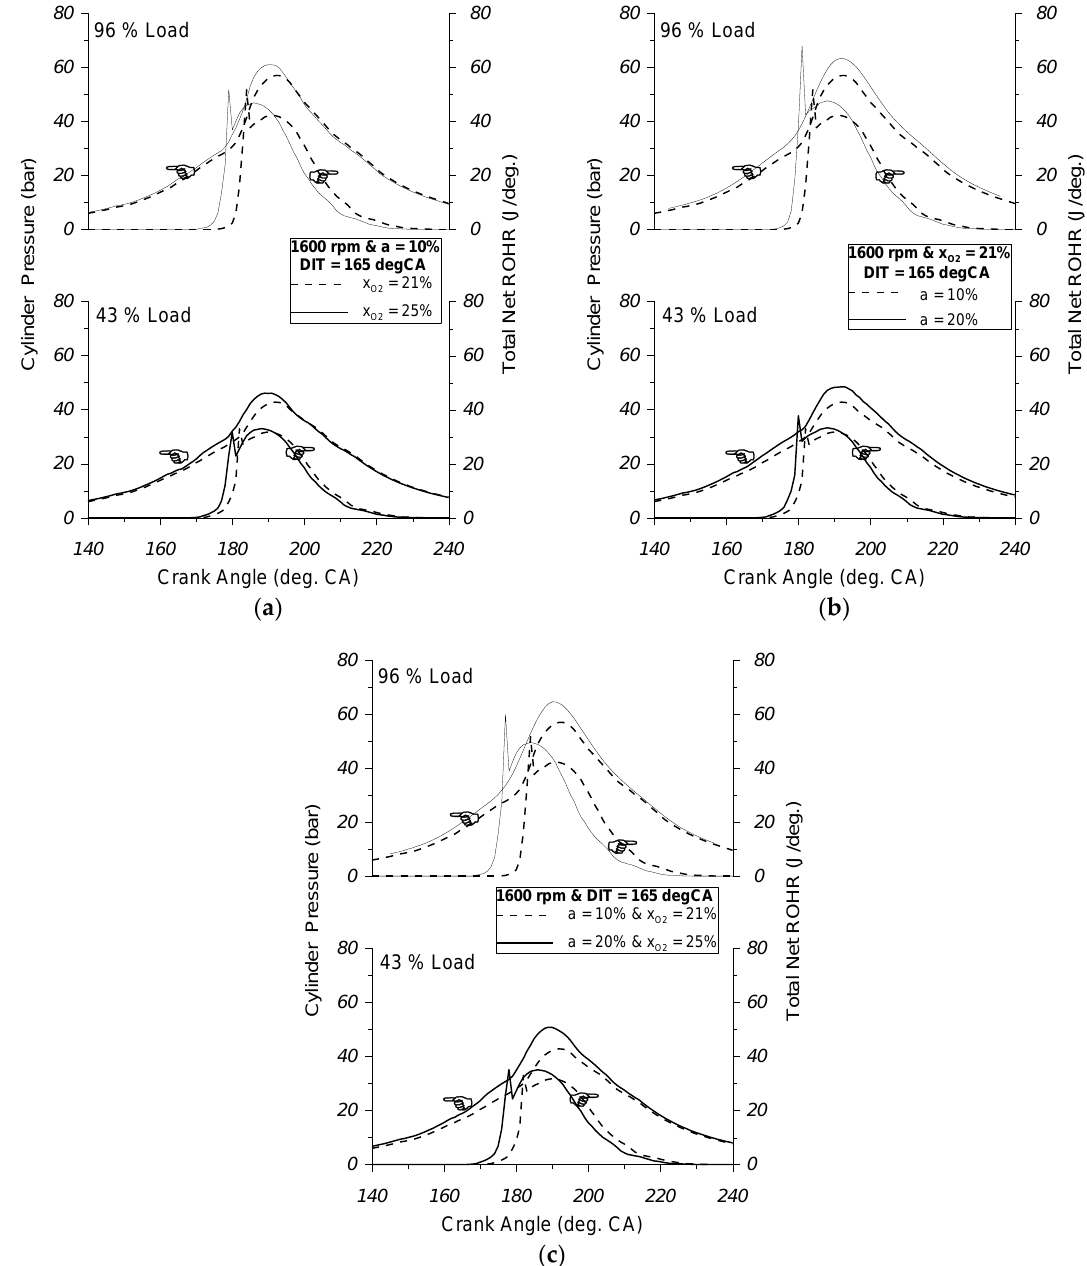
Figure 7. Calculated cylinder pressure and total RoHR diagrams of test engine operating under 1600 rpm engine speed, at 43% and 96% of engine rated load, for “x O2 ” = 21% and 25% & “a” = 10% ( a ); “a” = 10% and 20% & “x O2 ” = 21% ( b ); and “a” = 10% & “x O2 ” = 21% and “a” = 20% & “x O2 ” = 25% ( c ).